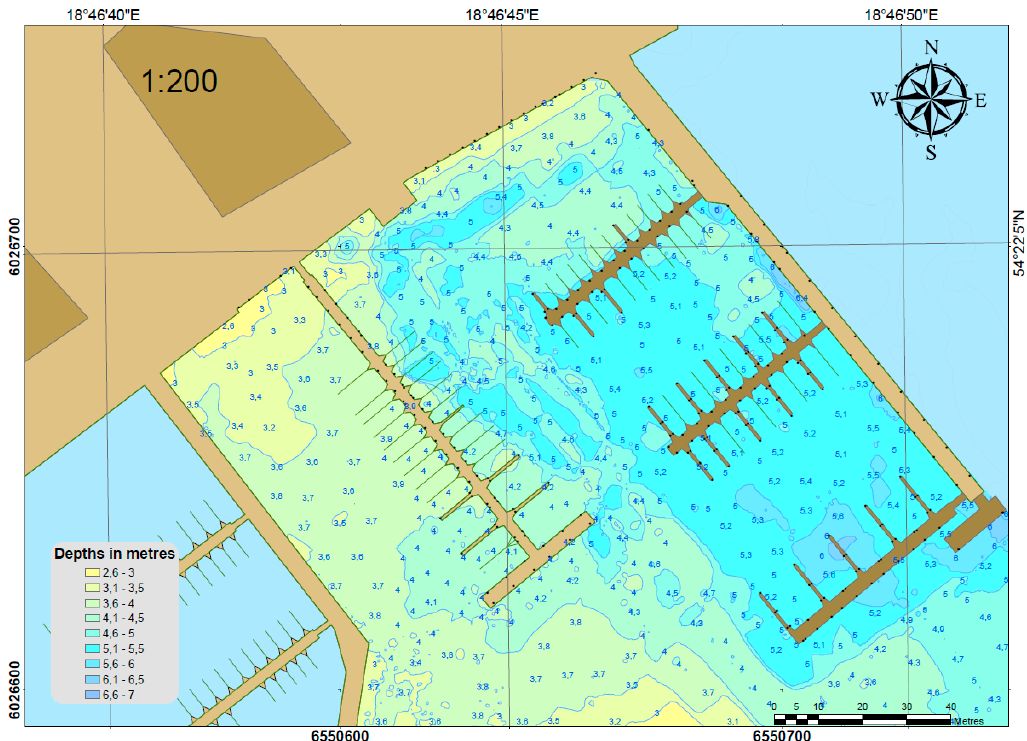
Figure 10. Navigational chart of the National Sailing Centre at the Gda ń sk University of Physical Education and Sport (NSC-GUPES).